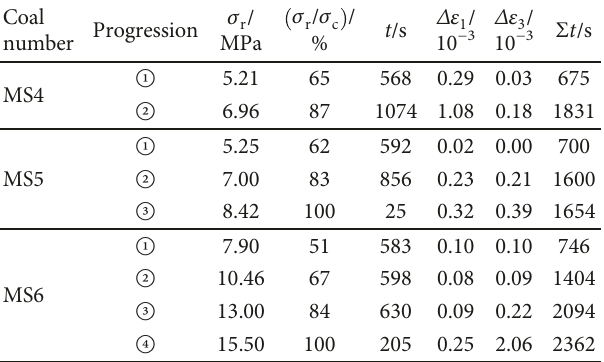
9Geo fl Table 3: Parameters of coal samples under step loading. Coal Progression number